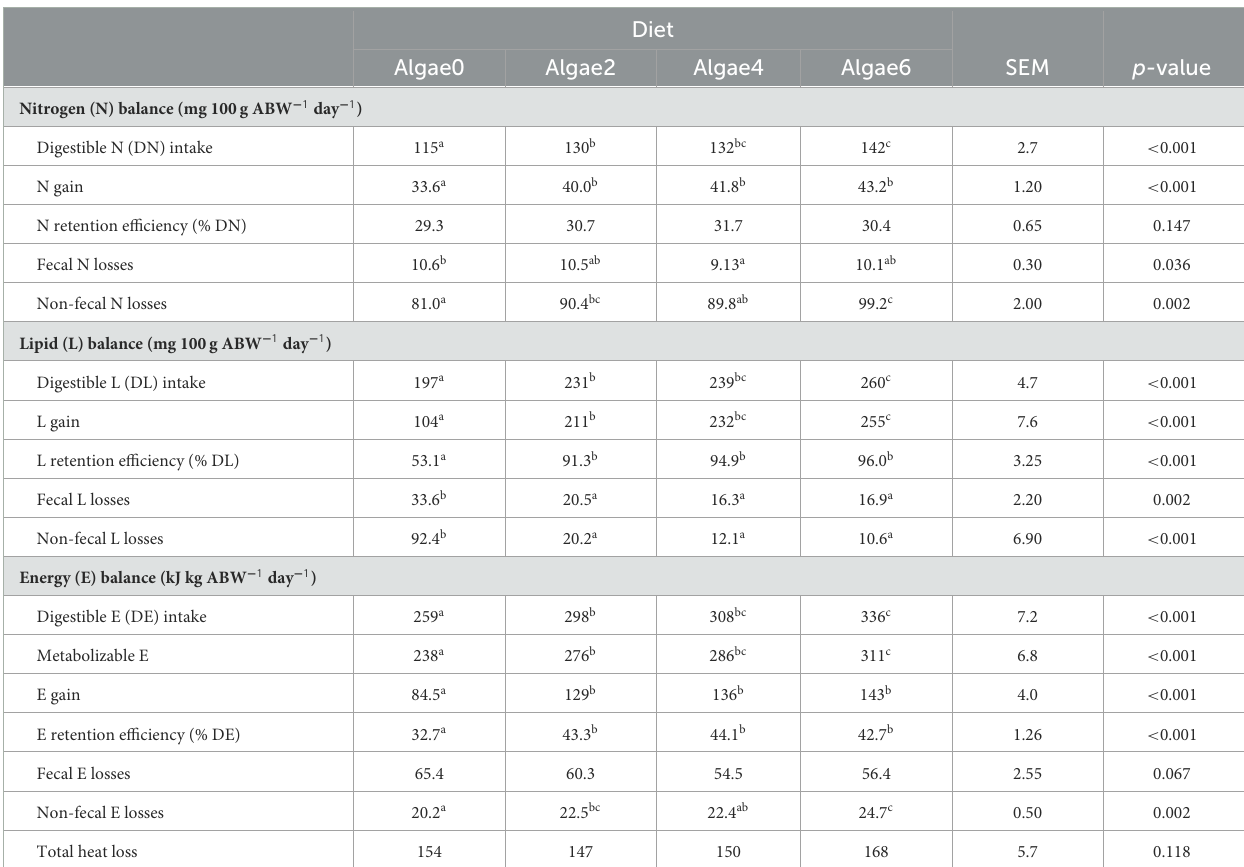
TABLE 3 Nutrient and energy balances of European seabass juveniles fed the experimental diets. Diet Algae0 Algae2 Algae4 Algae6 SEM p-